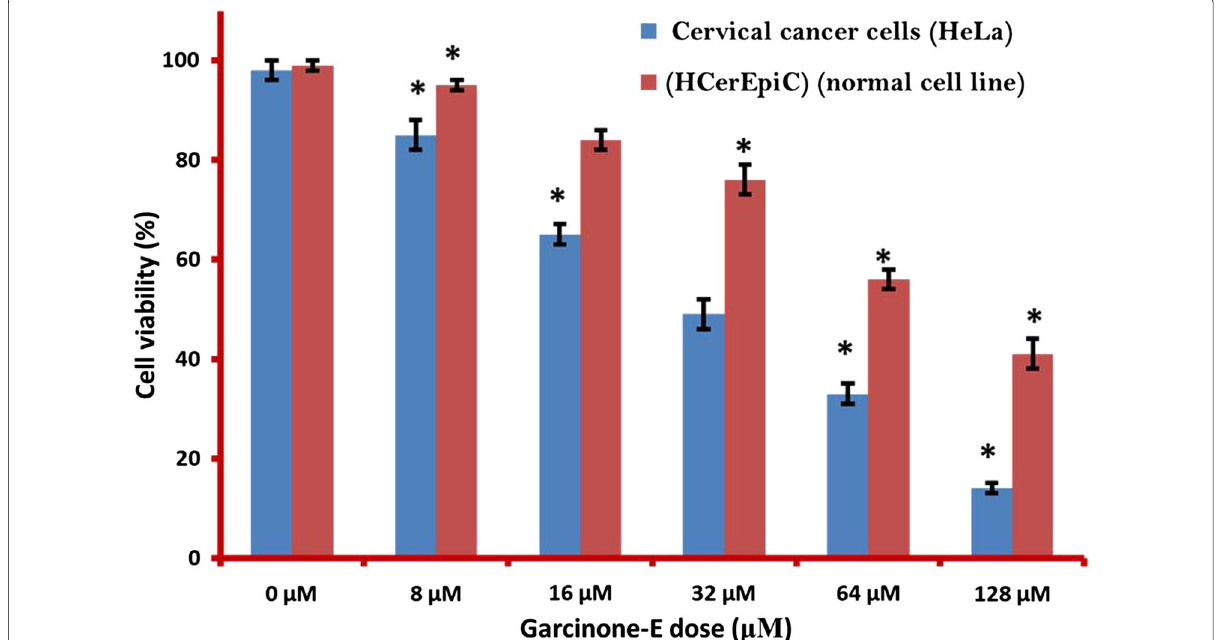
Fig. 3 MTT assay results indicating the rate of proliferation of cervical cancer HeLa cells and normal HCerEpiC human cervical epithelial cells. Both the cell lines were exposed to different time intervals of 24 h, 48 h and 72 h and variant concentrations (0–128 μM) of garcinone-E. Individual separate experiments were implemented three times considering p < 0.05 as statistically significant and data was signified as